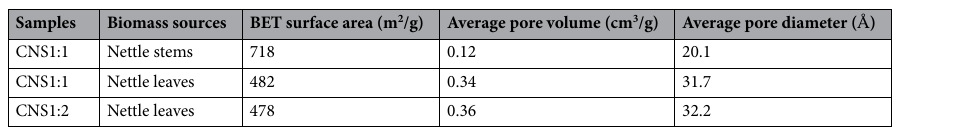
Table 1. BET surface area, average pore volume and average pore diameter of the prepared nettle-derived CNS at 650 °C, using different NaHCO 3 : tissue powder ratios.